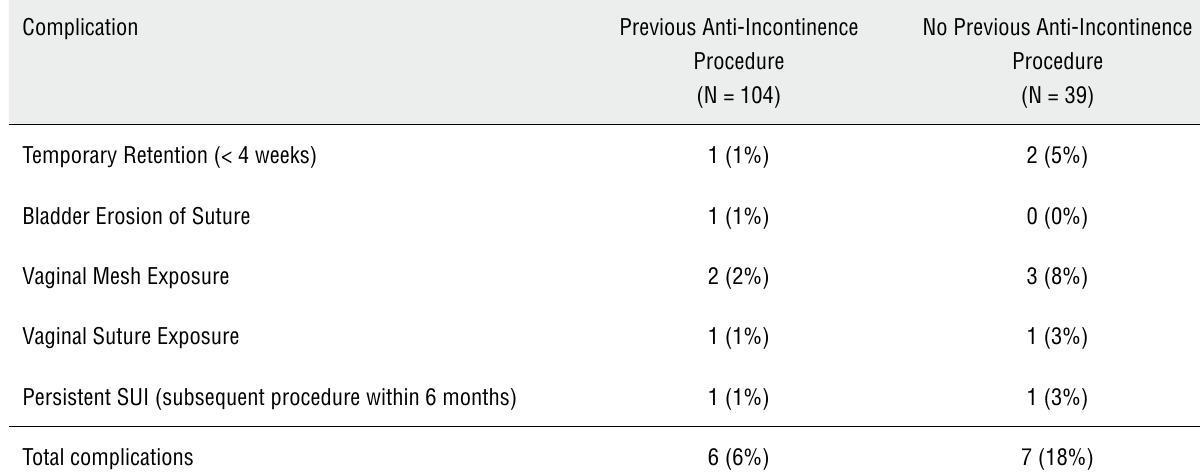
Table 3 - Complications following BAS surgery in patients with and without a history of previous anti-incontinence surgery.